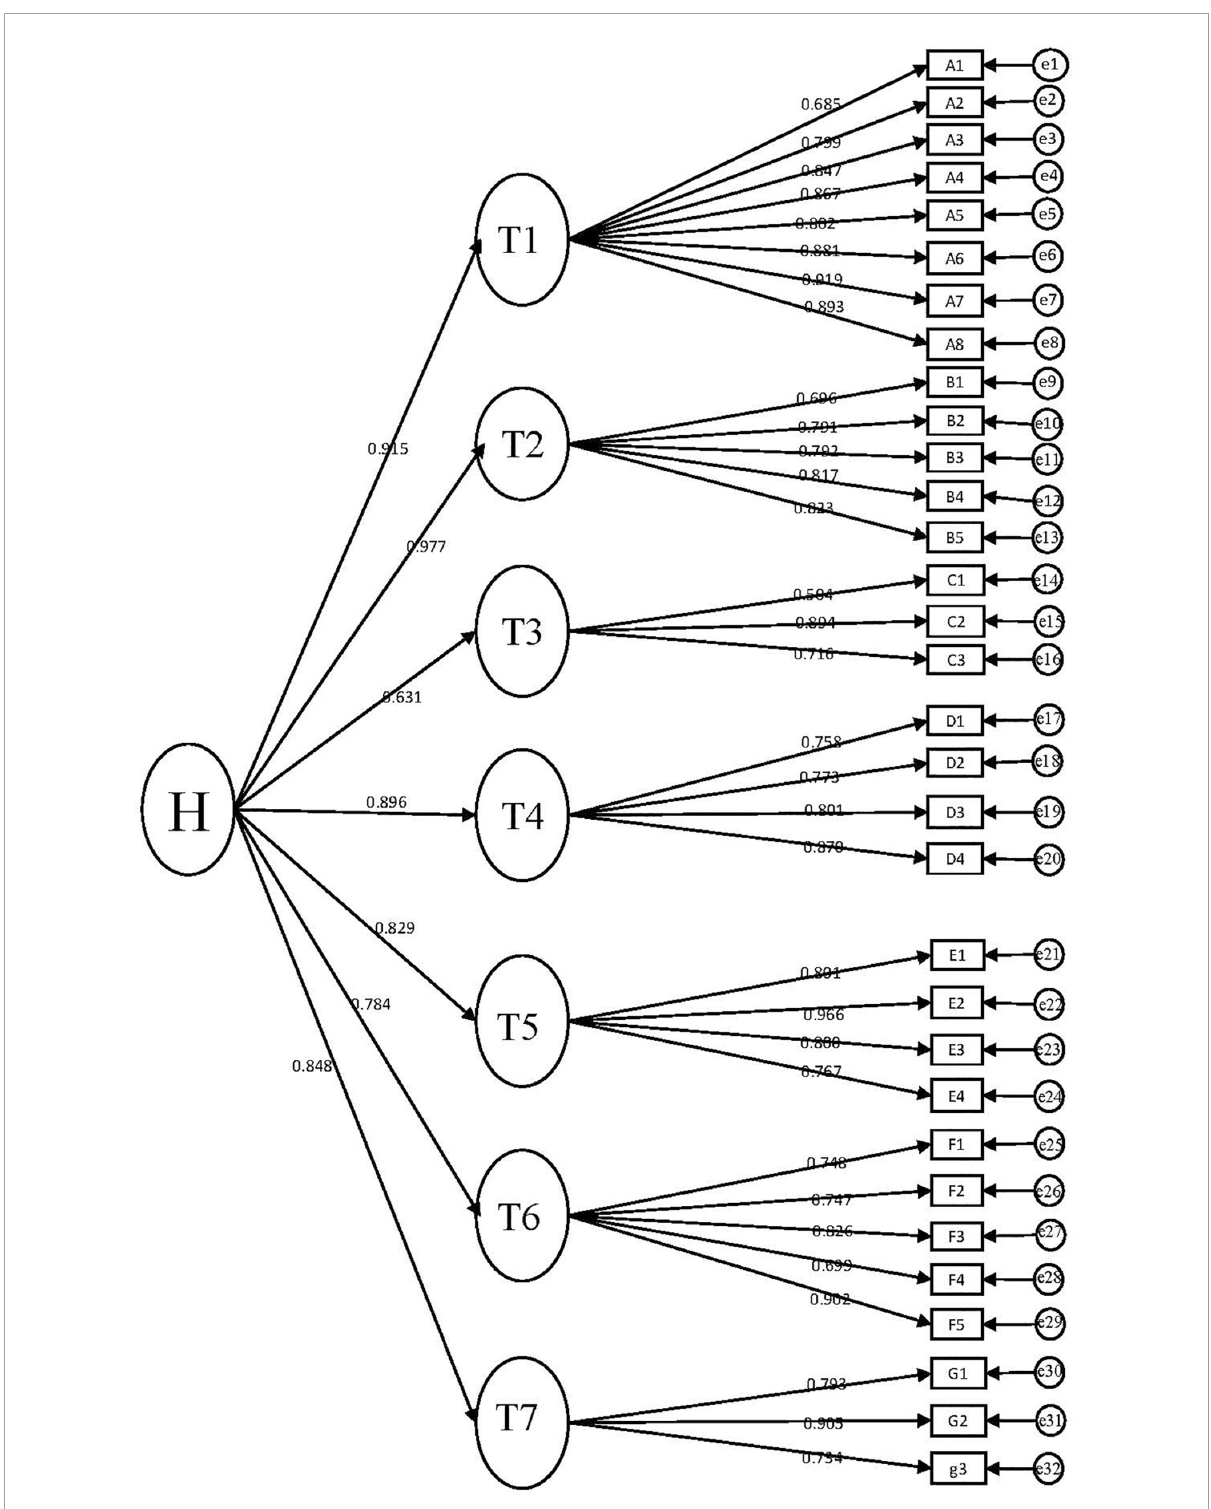
FIGURE2 Hypothesized second-order CFA. T1, translation classroom boredom; T2, under-challenging task boredom; T3, powerpoint presentation boredom; T4, homework boredom; T5, teacher-dislike boredom; T6, general learning trait boredom; T7, over-challenging or meaningless task boredom; H, boredom in translation